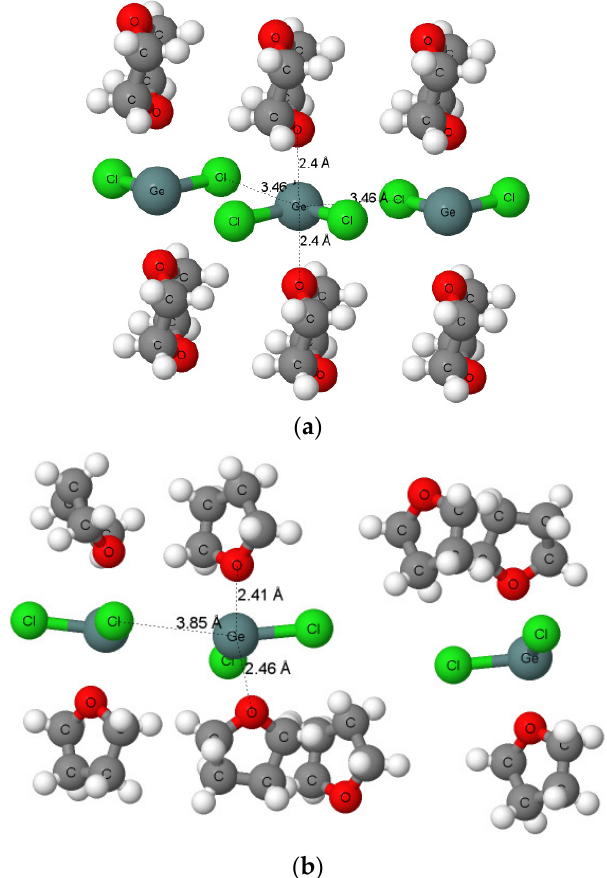
Figure 1. The fragments of the crystal structures; ( a ) 1,4-dioxane dichloro-germanium, ( b ) dichloro- germanium(ii) tetrahydrofuran solvate. The closest intermolecular contacts are indicated.